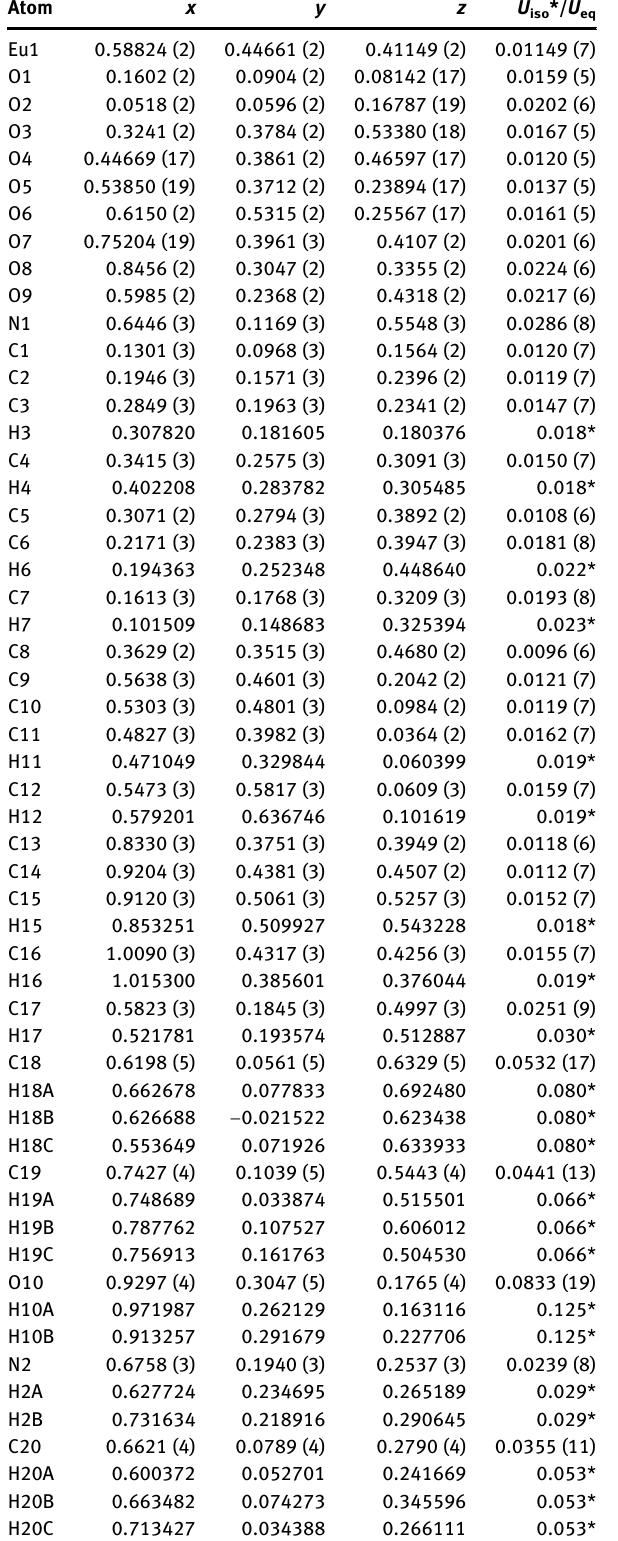
Table  : Fractional atomic coordinates and isotropic or equivalent isotropic displacement parameters (Å 